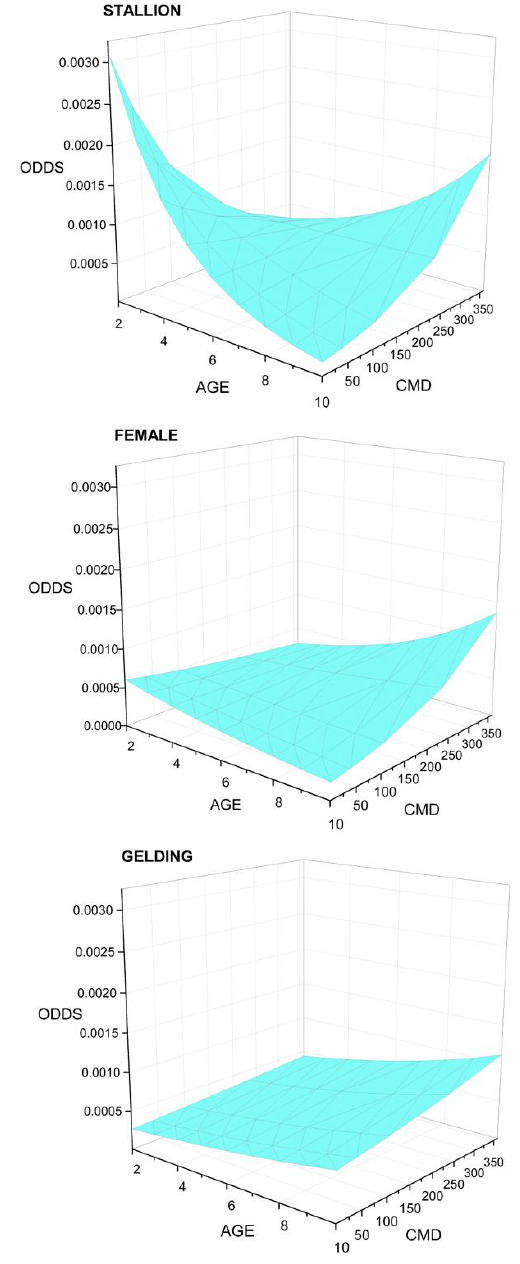
Figure 3. Odds of mortality by AGE, cumulative days raced in the season (CMD), and SEX for standardbred horses racing in the Province of Ontario from 2003–2015 and describing an AGE × CMD × SEX interaction identified in logistic regression analysis of mortality data from the Ontario Death Registry. Unit of interest for this analysis is work-event, population is work-events that finished normally (COMPLETED, n = 1,706,499). Three-dimensional response surfaces describe the interaction between AGE, CMD, and mortality odds for each sex group. Mortality patterns differ by SEX when all other factors are held constant. Patterns for stallions and females are similar but differ in degree, while pattern for the gelding shows a steady, progressive increase in liability with AGE and CMD.